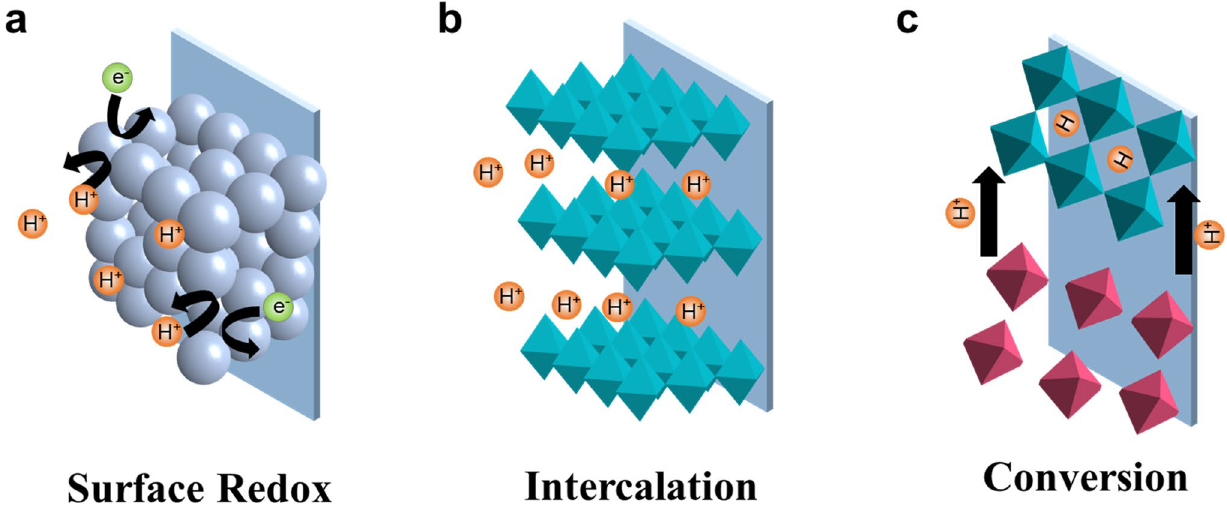
Fig. 2 Illustration of three types of charge storage mechanisms for electrochemical proton storage. a Surface redox reaction mechanism. b Inter- calation reaction mechanism. c Conversion reaction